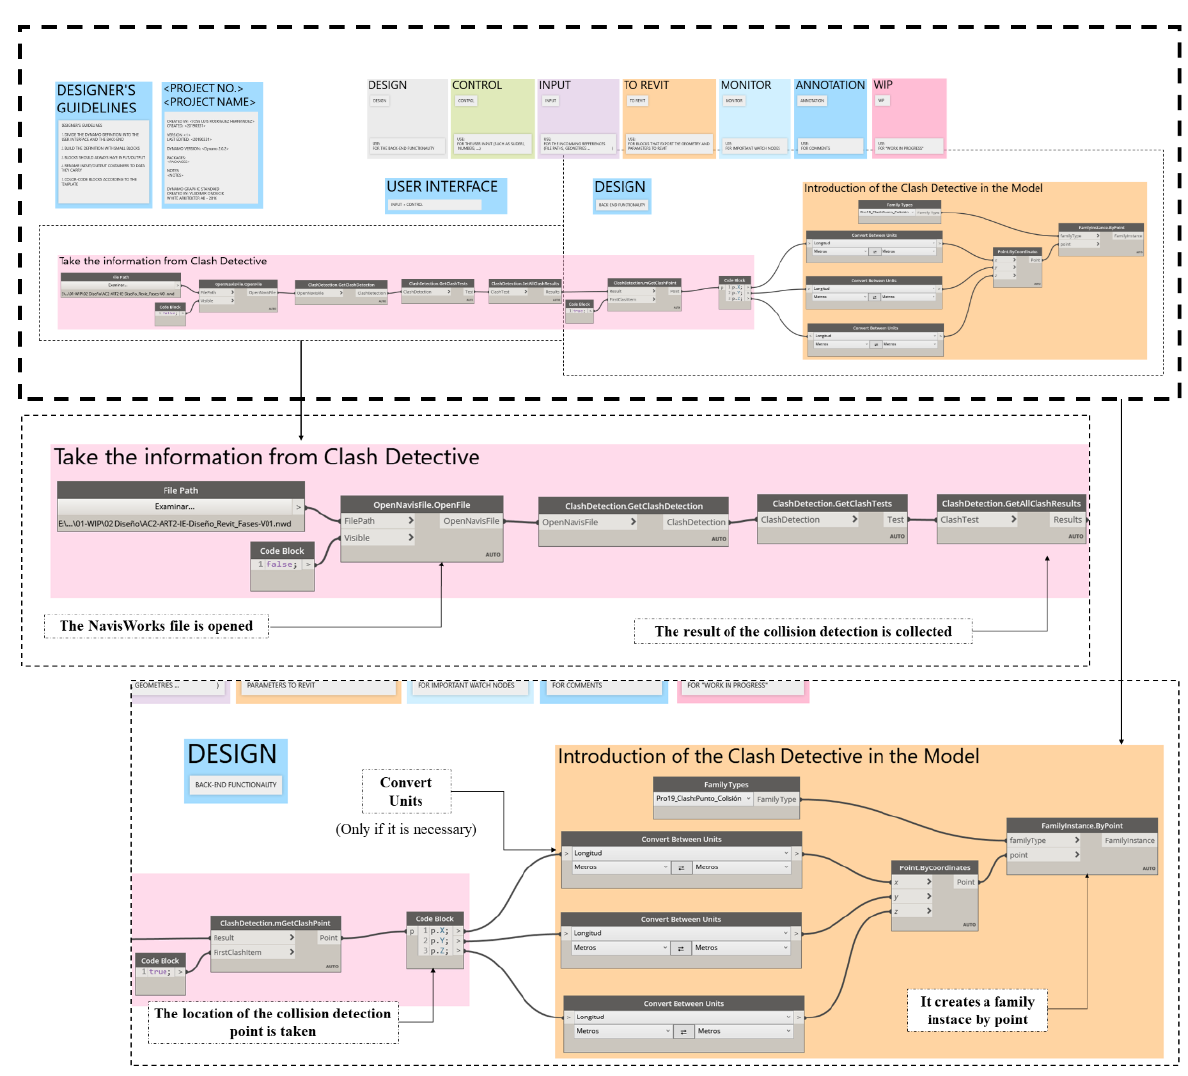
Figure 5. Image on top: general outline of the script. Intermediate image loading information from the point where the collision of the analysis envelope occurs. Bottom image: introduction of the collision point in the BIM model.